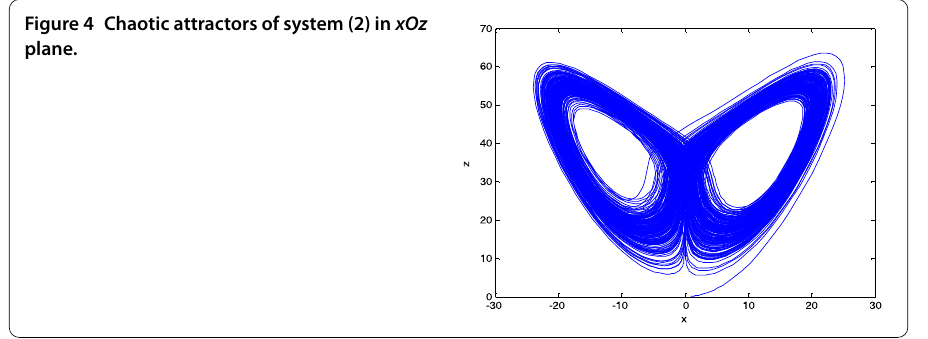
Figure 4 Chaotic attractors of system (2) in xOz